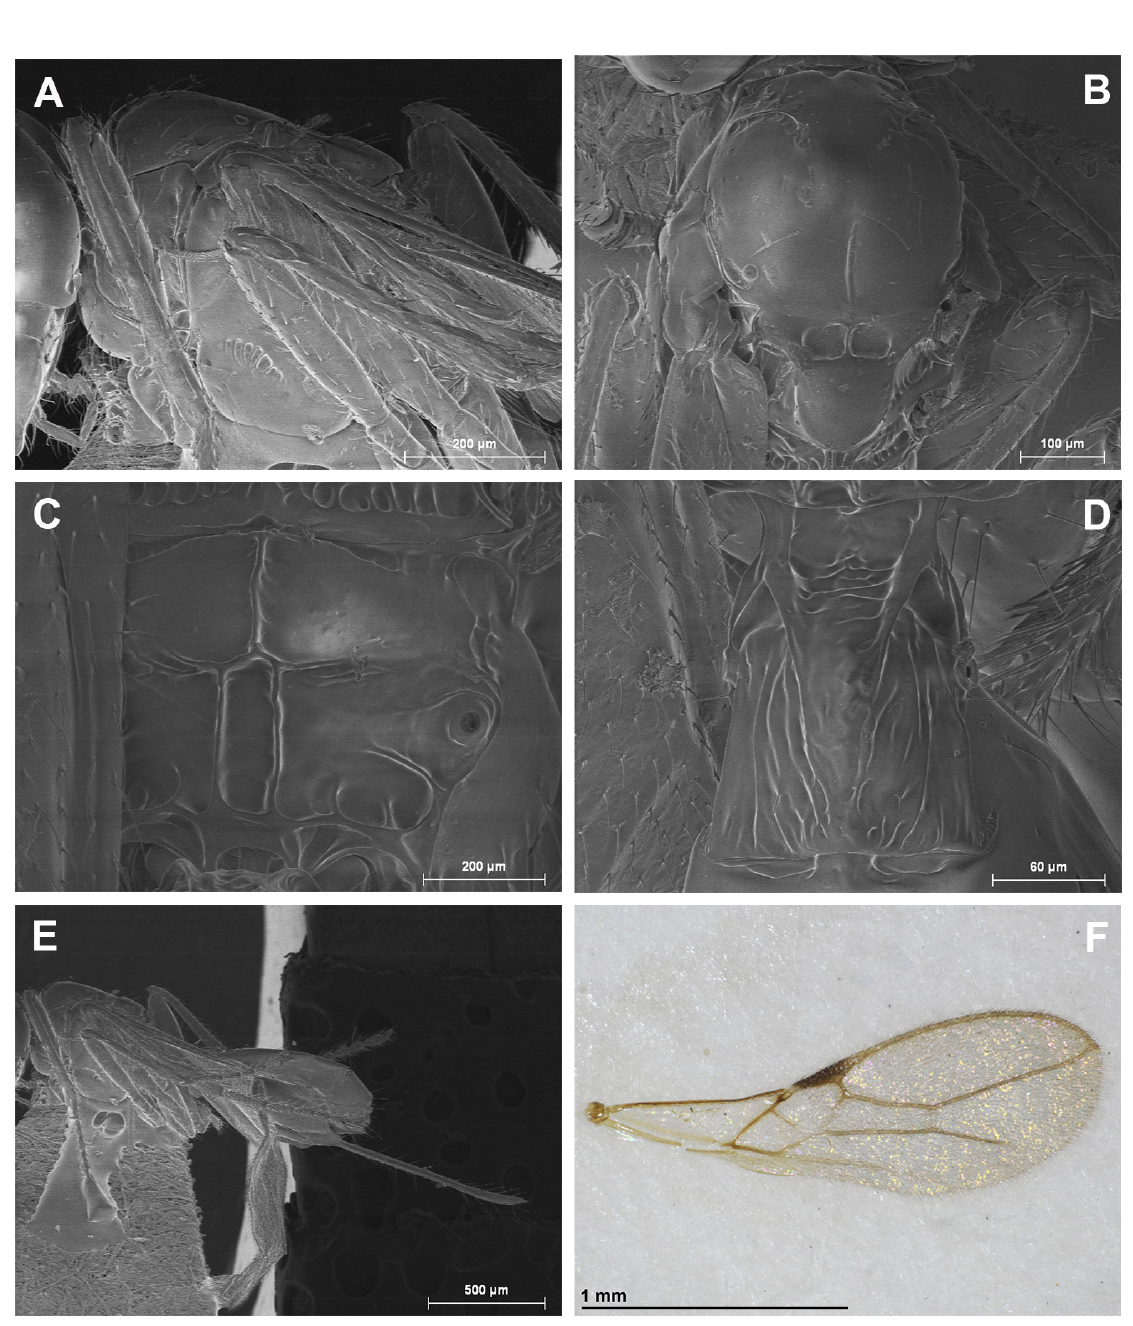
Fig. 38. Asobara malawaiana Fischer, 2007, ♀, holotype (OLML). A . Mesosoma, lateral view. B . Mesoscutum, dorsal view. C . Propodeum. D . First metasomal tergite, dorsal view. E . Hind leg, metasoma and ovipositor, lateral view. F . Fore